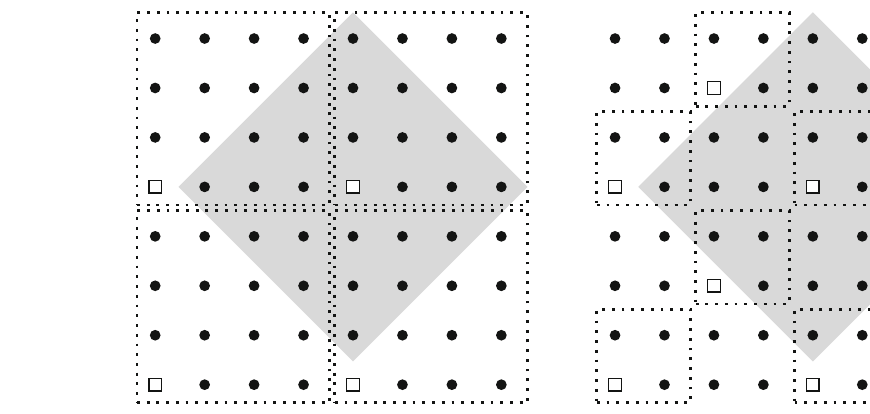
Fig. 8 Two schemes of probing vectors suitable for a matrix whose generic column has non-zero entries on the sites within the shaded region. Left: the probing vectors have support, e.g. white squares, on one point of each of the squared blocks. The column of the matrix